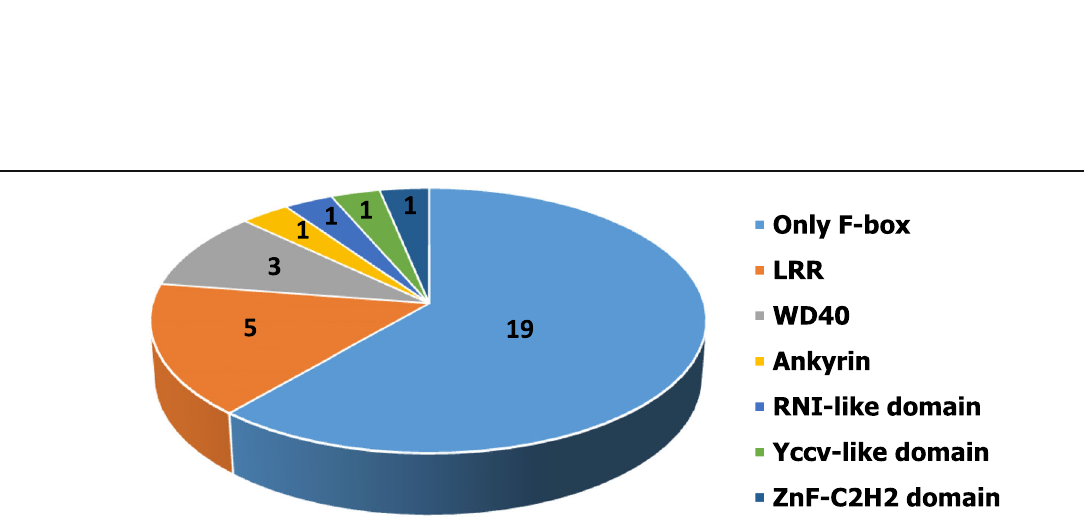
Fig. 4 Classification of F-box proteins in M. phaseolina. The number of F-box proteins were classified and shown in